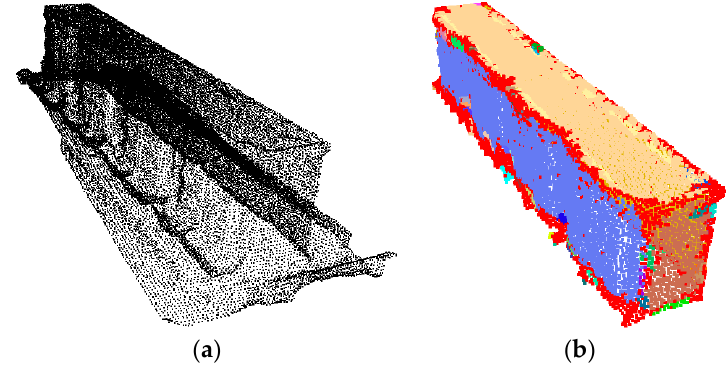
Figure 6. Results of pre-processing and initial segmentation: ( a ) original point cloud of a building; and ( b ) point cloud after filtering the ground points and initial segmentation.